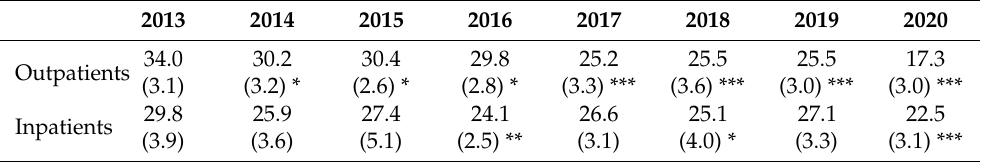
Table 4. Days of therapy of included patients who received oral quinolones from 2013 and 2020.